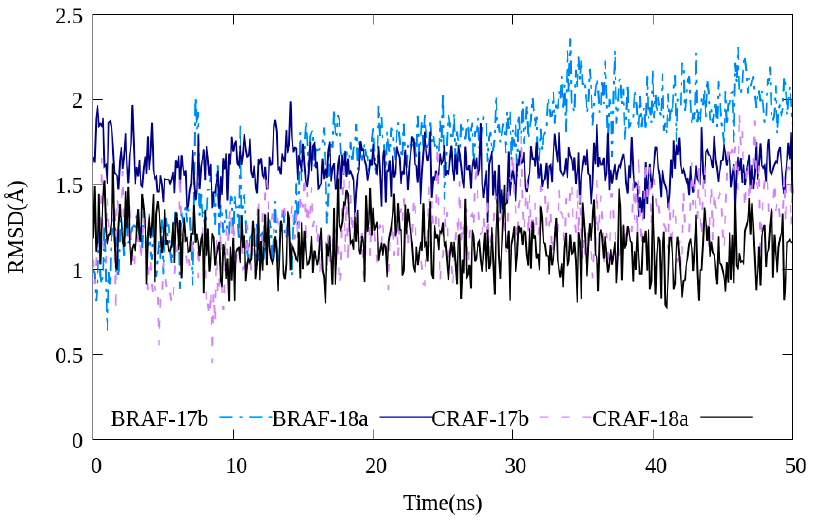
Figure 8. RMSD values of compounds 17b and 18a during 50 ns of molecular dynamics simulations.